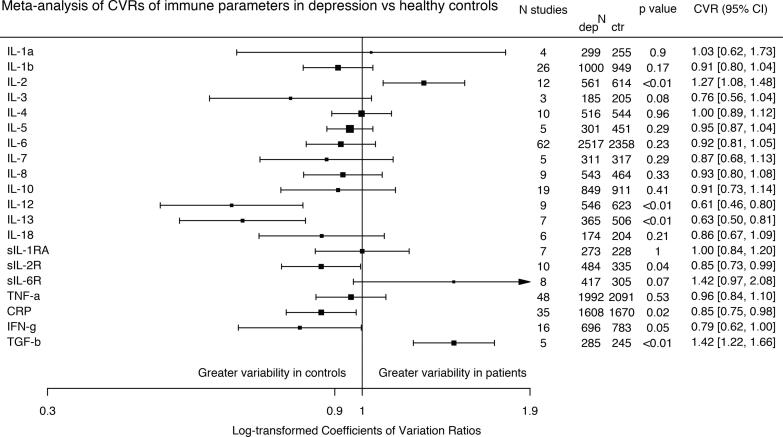
Forest plot showing effect sizes for mean-scaled variability of immune parameters in depression compared with healthy controls. The coefficient of variation ratio (CVR) was significant decreased for IL-12, IL-13, IL-2R, CRP, and IFNγ, indicating lower variability of these immune parameters in patients compared with controls, and significantly increased for IL-2 and TGF β, indicating increased variability of these immune parameters in patients compared with controls.